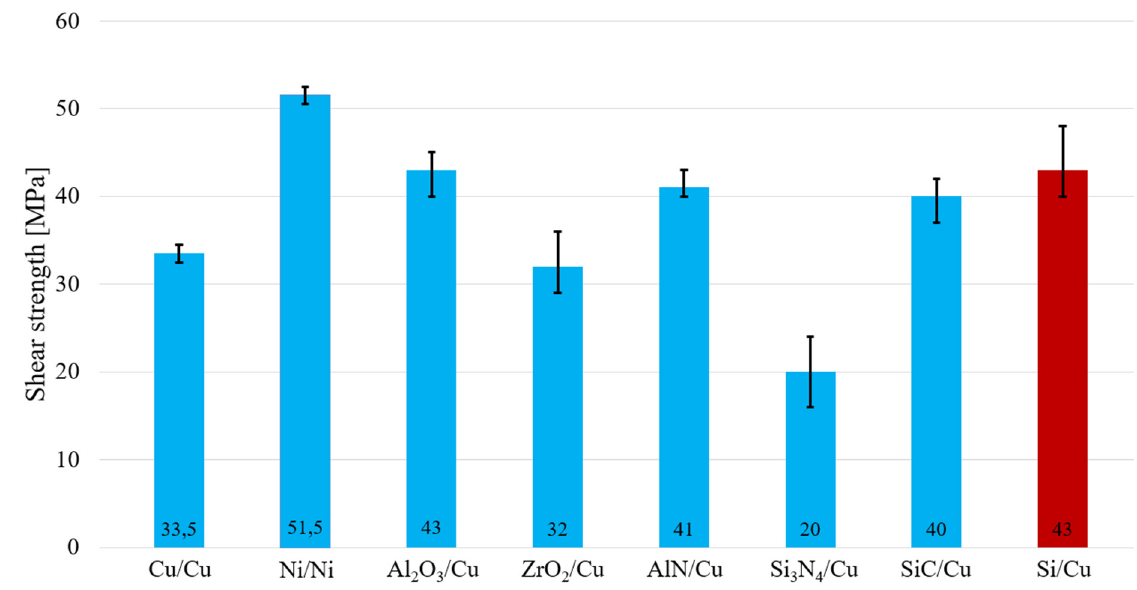
Figure 22. Shear strength of soldered joints fabricated with Bi11Ag1.5Ti solder.